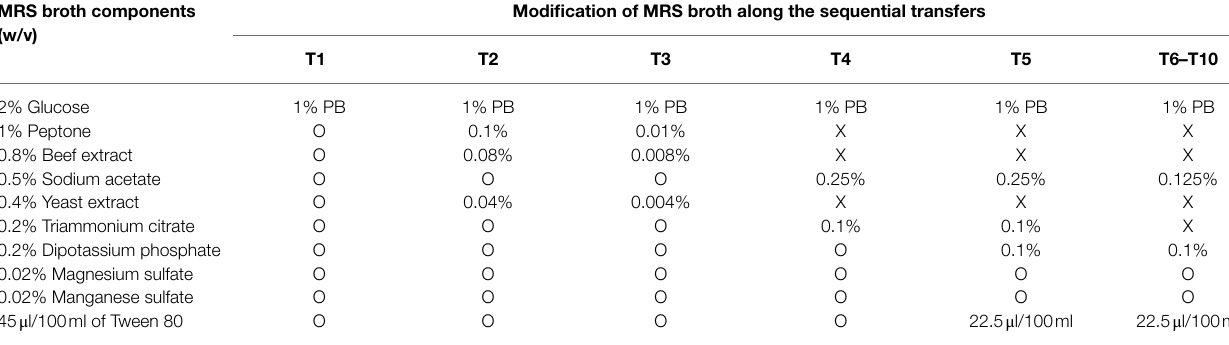
The table shows the composition of modified medium for each enrichment step; all values are % (w/v) except for Tween 80 which is a volume ratio. (O) means the same percentage used in original MRS broth. (X) means the absence of this component within the modified culture medium. At T1, we replaced 2% glucose to 1% of PB and maintained it the same concentration in the subsequent